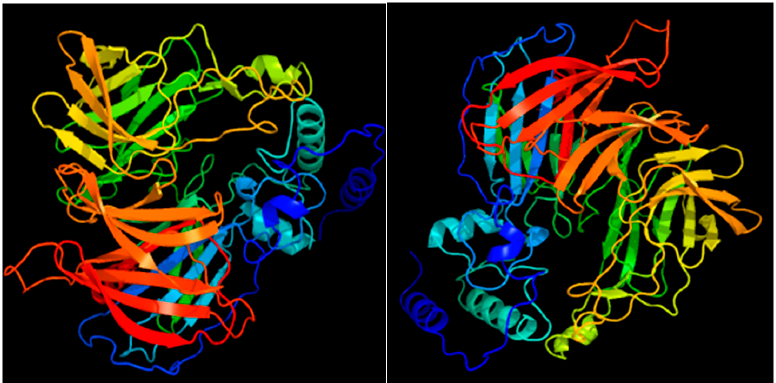
Figure 4. The 3D prediction structures of the SlCCD1A and SlCCD1B proteins in tomatoes.